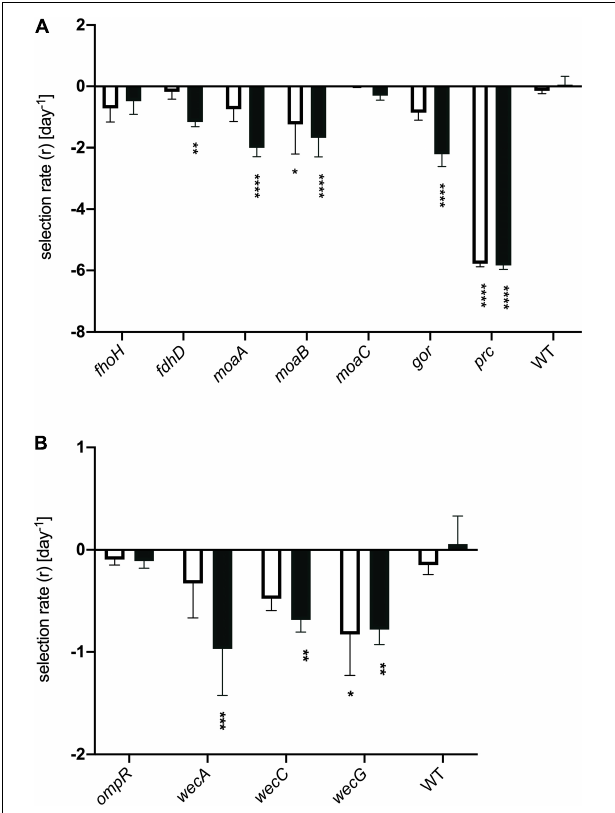
FIGURE 6 | Selection rates for strains deleted for individual genes. Genes classified in the TraDIS dataset as having (A) negative fitness or (B) positive fitness when containing transposon insertions. Strains were mixed with represented their wild type parent ( E. coli MG1655, marked with a lacZ mutation) in model honey for 30 min (plain bar) or 90 min (black bar), before plating on MacConkey lactose to determine relative survival rates. The WT control shows the data for MG1655 lacZ mixed with MG1655 LacZ + . Data were analyzed using two-way ANOVA: asterisks show significance levels of Sidak’s multiple comparisons test (**** p ≤ 0.0001, *** p ≤ 0.0005, ** p ≤ 0.005, * p ≤ 0.05); all bars without asterisks are not significant ( p > 0.05). Error bars represent the average ± SD ( n = 3; independent biological replicates).